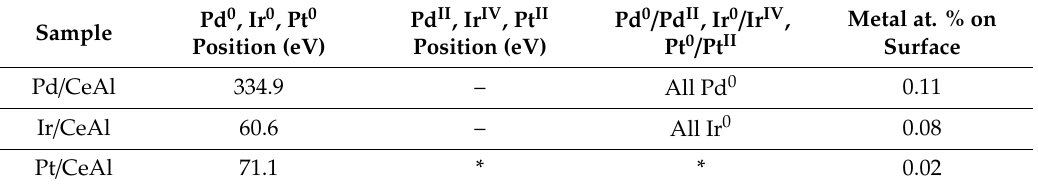
Figure 5. ( a ) Ir 4f spectra of the Ir / CeAl, ( b ) Pd 3d spectra of Pd / CeAl and ( c ) Al 2p / Pt 4f of the Pt / CeAl reduced catalysts. Table 2. XPS data of the reduced catalysts.